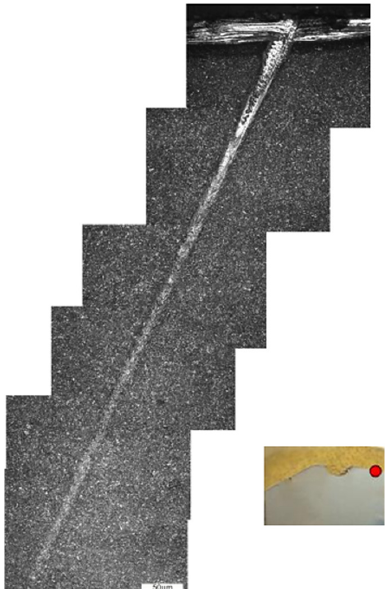
Figure 13. Effect of changes in die material microstructure due to intense subsurface interaction (adiabatic shear band). Red dot indicates the area of metallographic observations.